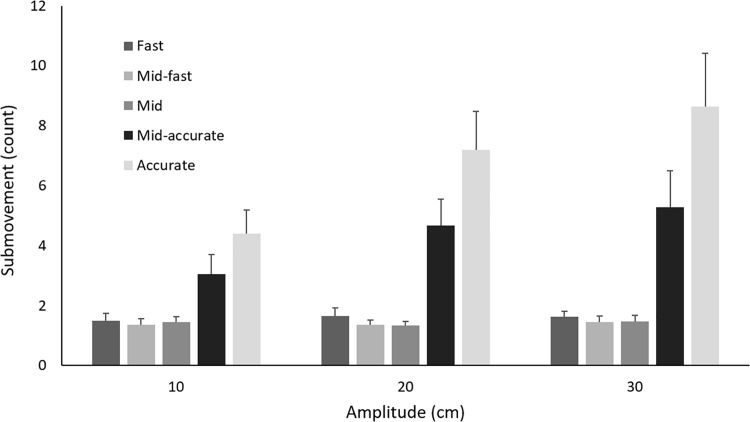
The average number of submovements for 3 different amplitudes as a function of space-time conditions.The error bars represent the between-participant standard deviation.